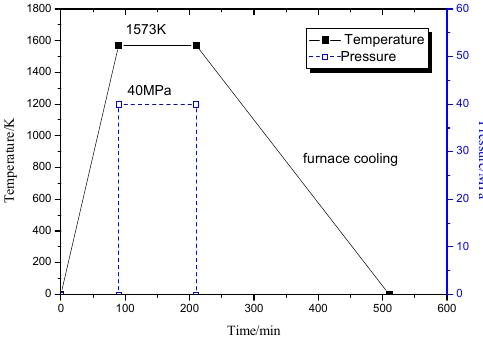
Figure 2. Time/temperature/pressure pro fi le used in thermal mechanical processing.